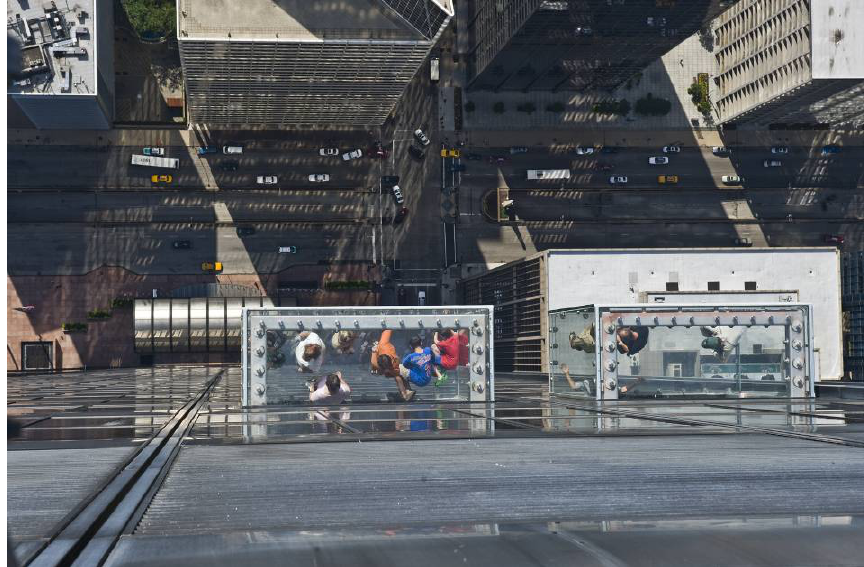
Figure 6: View of glass boxes from above